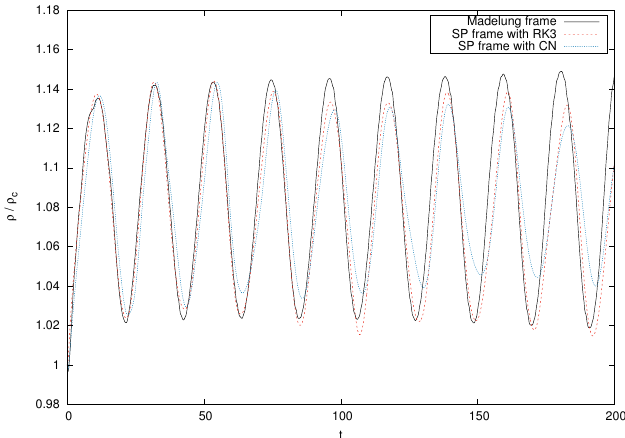
Figure 2. Central density | Ψ ( (cid:126) 0, t ) | 2 for the solution in the SP frame and ρ ( (cid:126) 0, t ) in the Madelung frame, as functions of time. This plot shows that the first oscillation mode is similar, although not perfectly equal in the two frames. In the SP frame, the period coincides with that in [16], whereas the period in the Madelung frame shrinks in time.